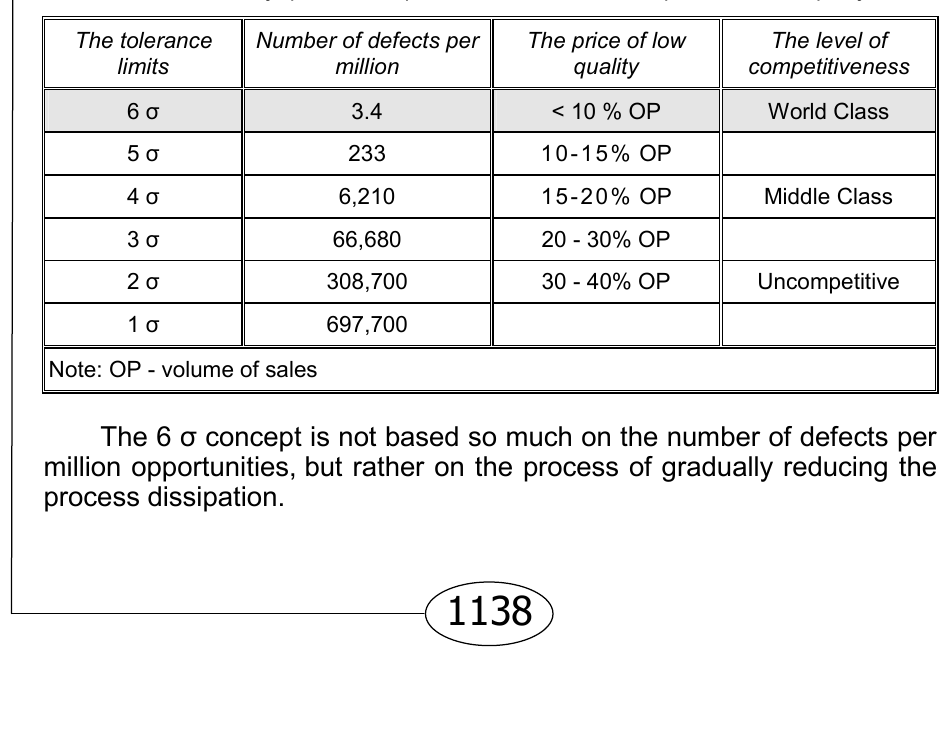
Table 3 – The process capability impact on the competitiveness of companies Таблица 3 – Влияние процессов на конкурентоспособность